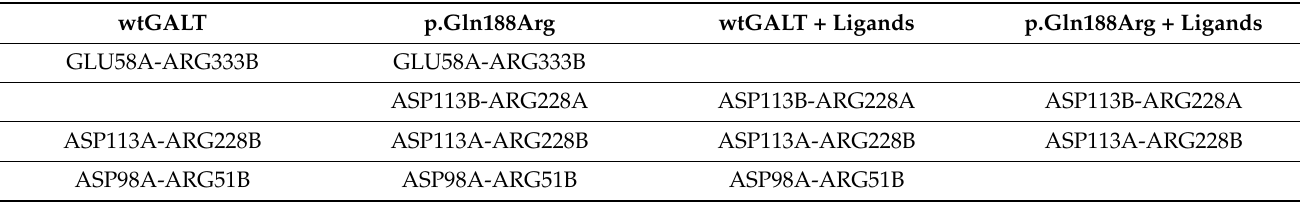
Table 2. Couples of residues involved in stable intersubunit salt bridges in simulations at 310 K. Couples of residues are considered to have a stable salt bridge interaction when the sum of % of existence of the salt bridges between the two residues is ≥ 50.